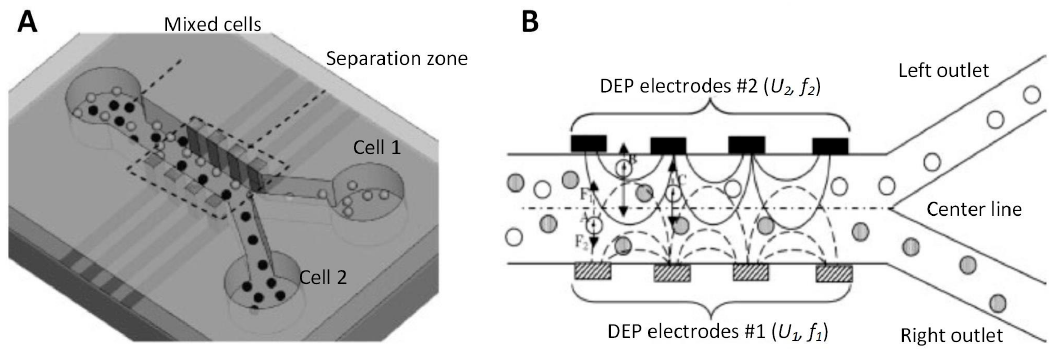
Figure 10. A vertical thin-film device and the 2D thin-film electrodes were used as 3D electrodes. Reproduced with permission from [28], © 2009 John Wiley and Sons. ( A ) Schematic of the device. ( B ) The drawing of the cell separation in the separation zone.